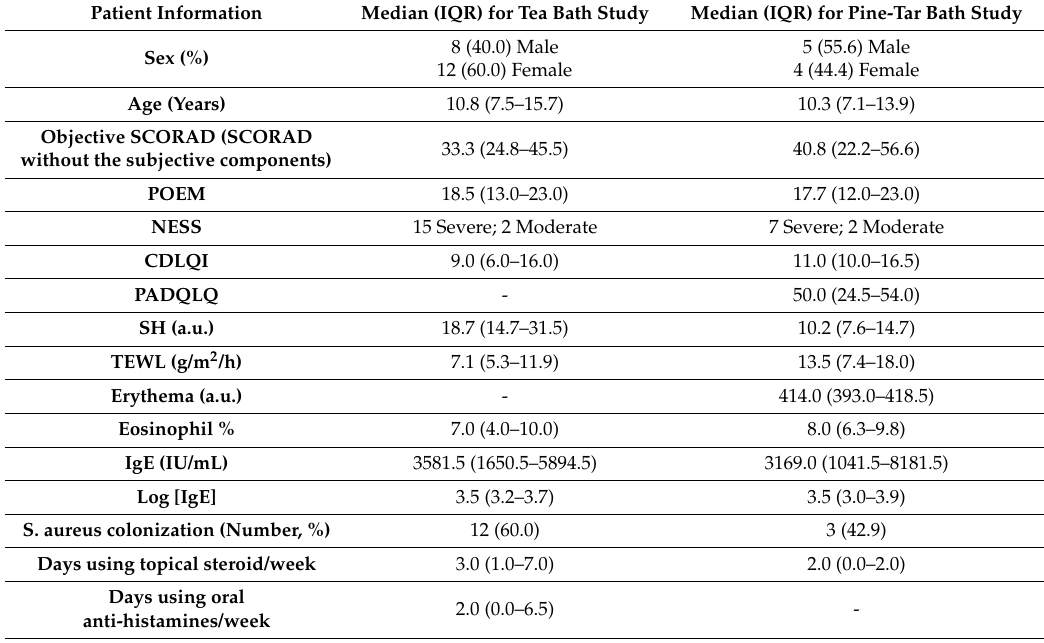
Table 1. Patient demographics of the Tea bath ( n = 20) and Pine-tar bath ( n = 9) study.